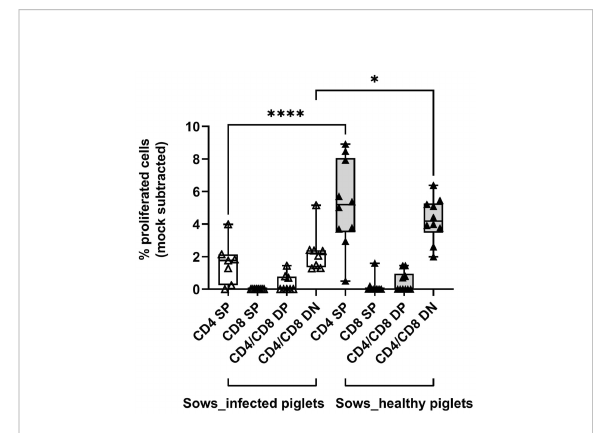
FIGURE 6 Proliferative responses of T cells from sows that delivered infected or healthy piglets to PRRSV-1 JA2 stimulation. PBMC labeled with CellTrace Violet were stimulated in vitro with the circulating fi eld virus at MOI 0.1. After 3 days, a fi ve-color staining, live/dead Near-IR/CD3/CD4/CD8 a /CD16, was performed. In each T cell subset (CD4 SP, CD8a SP, CD4/CD8a DP, and CD4/CD8a DN), the proportion of CellTrace Violet dim cells was de fi ned as the ratio of proliferation. Mock-stimulated cells were subtracted from the virus-stimulated cultures. Empty boxes, sows delivering JA2-infected piglets; grey- fi lled boxes, sows delivering healthy piglets. Statistical signi fi cance was measured by the Mann – Whitney nonparametric test, * p < 0.05, **** p <